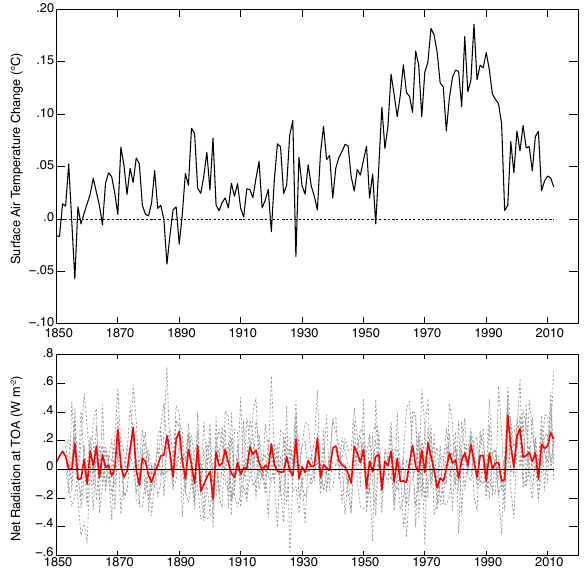
Fig. 24. Global mean annual average temperature change due to ozone forcing (top; ensemble mean) and net radiation at the top- of-the-atmosphere (TOA) in response to ozone forcing (red solid ensemble mean; black dashed individual